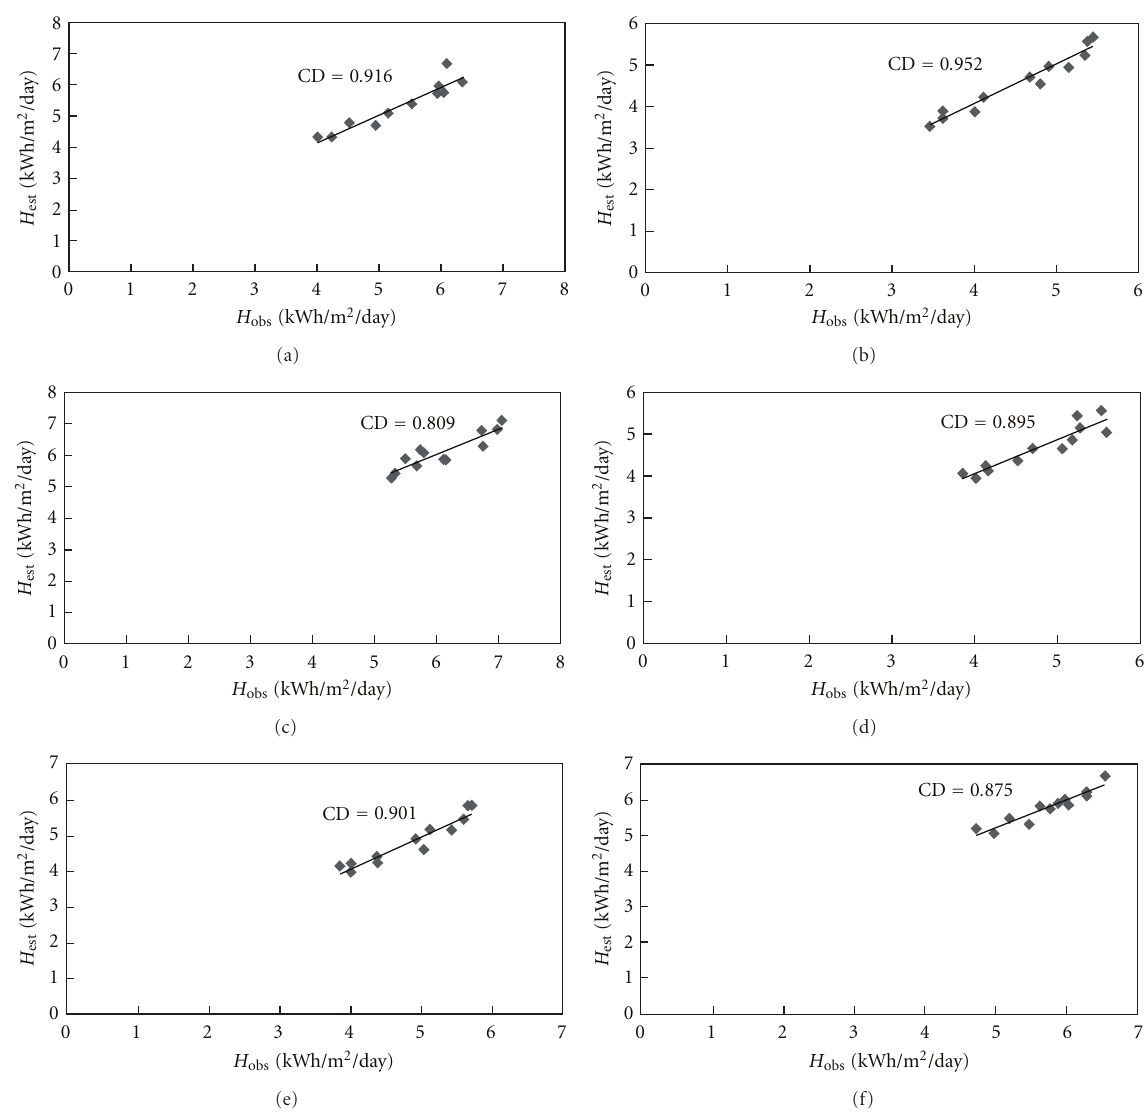
Figure 2: Correlation between the estimated and observed values of the monthly mean daily global solar radiation. (a) Abuja, (b) Benin City, (c) Katsina, (d) Lagos, (e) Nsukka, and (f)